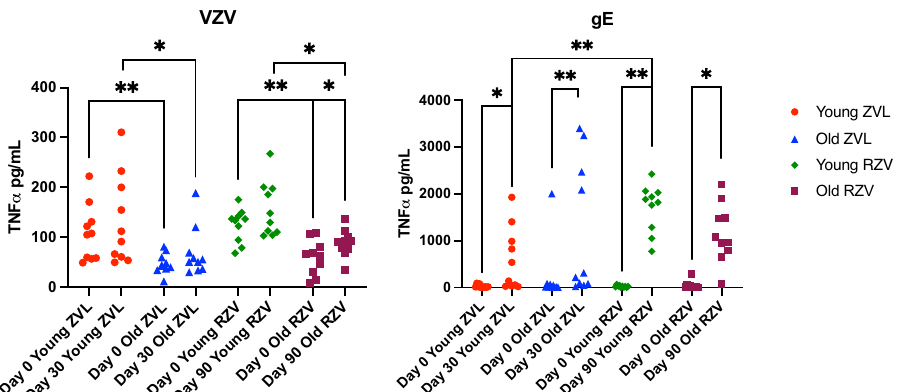
Fig. 2 Effect of Zoster Vaccines on VZV-Speci fi c ADCC. Data were derived from 40 individuals equally distributed between young and old ZVL or RZV recipients. Shown are TNF α concentrations measured by ELISA before vaccination and at peak response to each vaccine against VZV ( left panel ) and gE ( right panel ). Bars indicate medians and quartiles. Signi fi cant differences are shown on the graph and marked by *0.01 < p < 0.05 or **0.001 < p <